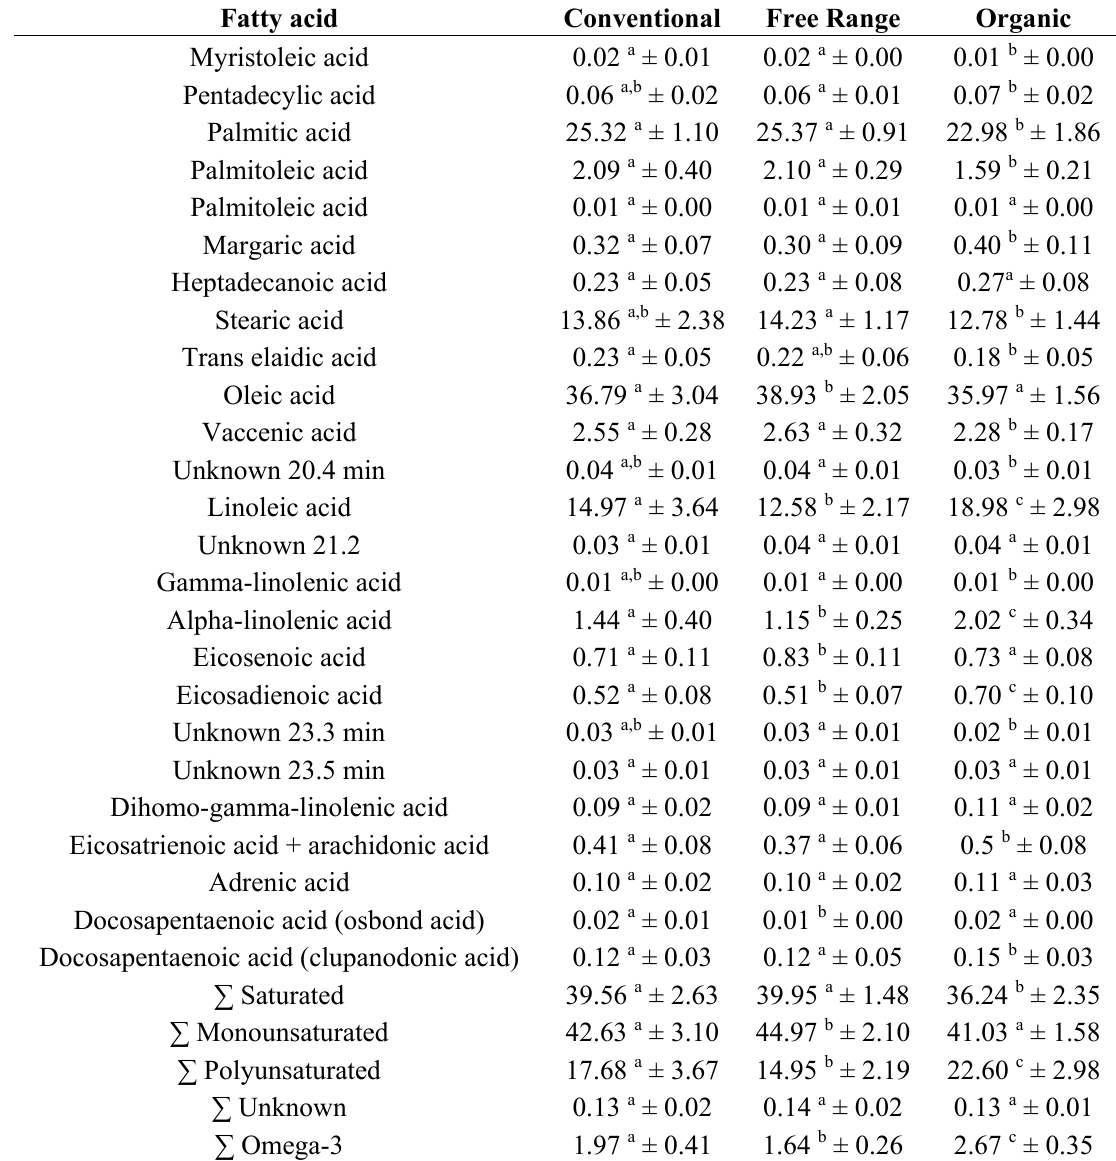
Table 2. Fatty acid composition of pork belly meat from the categories conventional, free range, and organic expressed as percentage of normalized peak